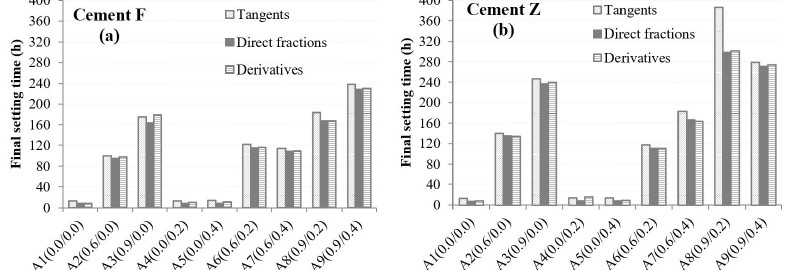
Figure 11. Final setting times obtained by different methods for mortars with cements F and Z.